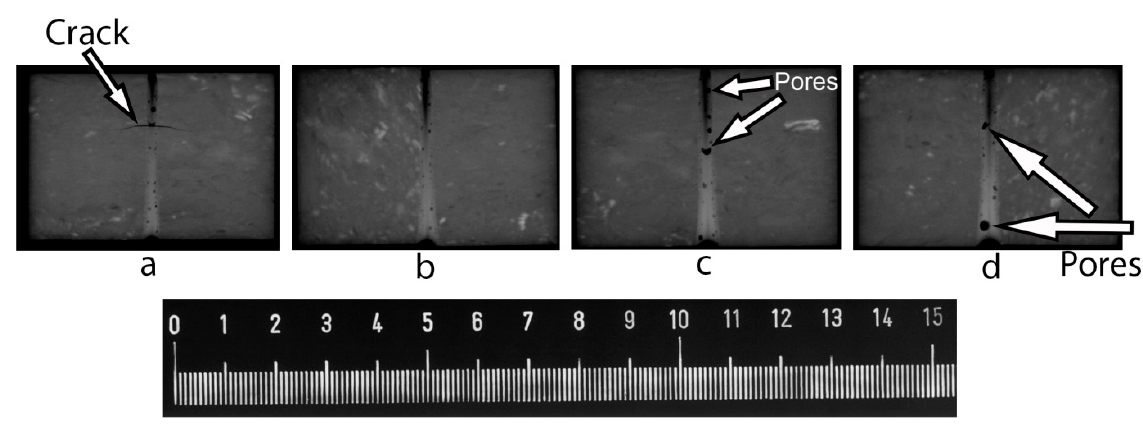
Figure 3. Radiographs images of the general view of welded samples obtained at different pre-heating temperatures: without pre-heating ( a ); 200 °C ( b ); 400 °C ( c ); or 600 °C ( d ).